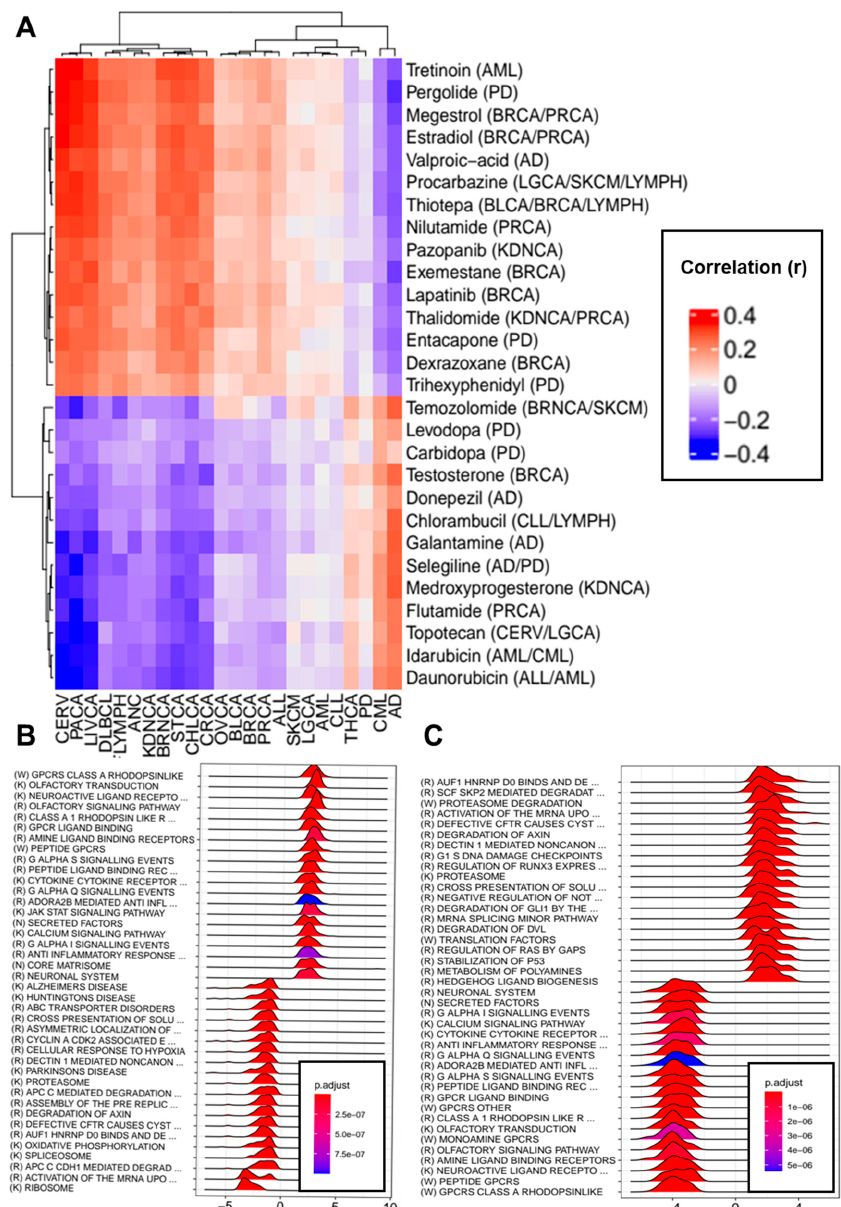
Figure 6. ( A ) Top associated drugs indicated for cancer treatment based on their correlations with AD, PD, and cancer signatures. Red and blue represent positive and negative correlations, respectively. The disorder/s for which a particular drug is indicated can be found between brackets after the drug name. ( B ) Riddle plot depicting the top 10 up- and downregulated pathways induced by treatment with galantamine. ( C ) Riddle plot depicting the top 10 up- and downregulated pathways induced by treatment with exemestane.